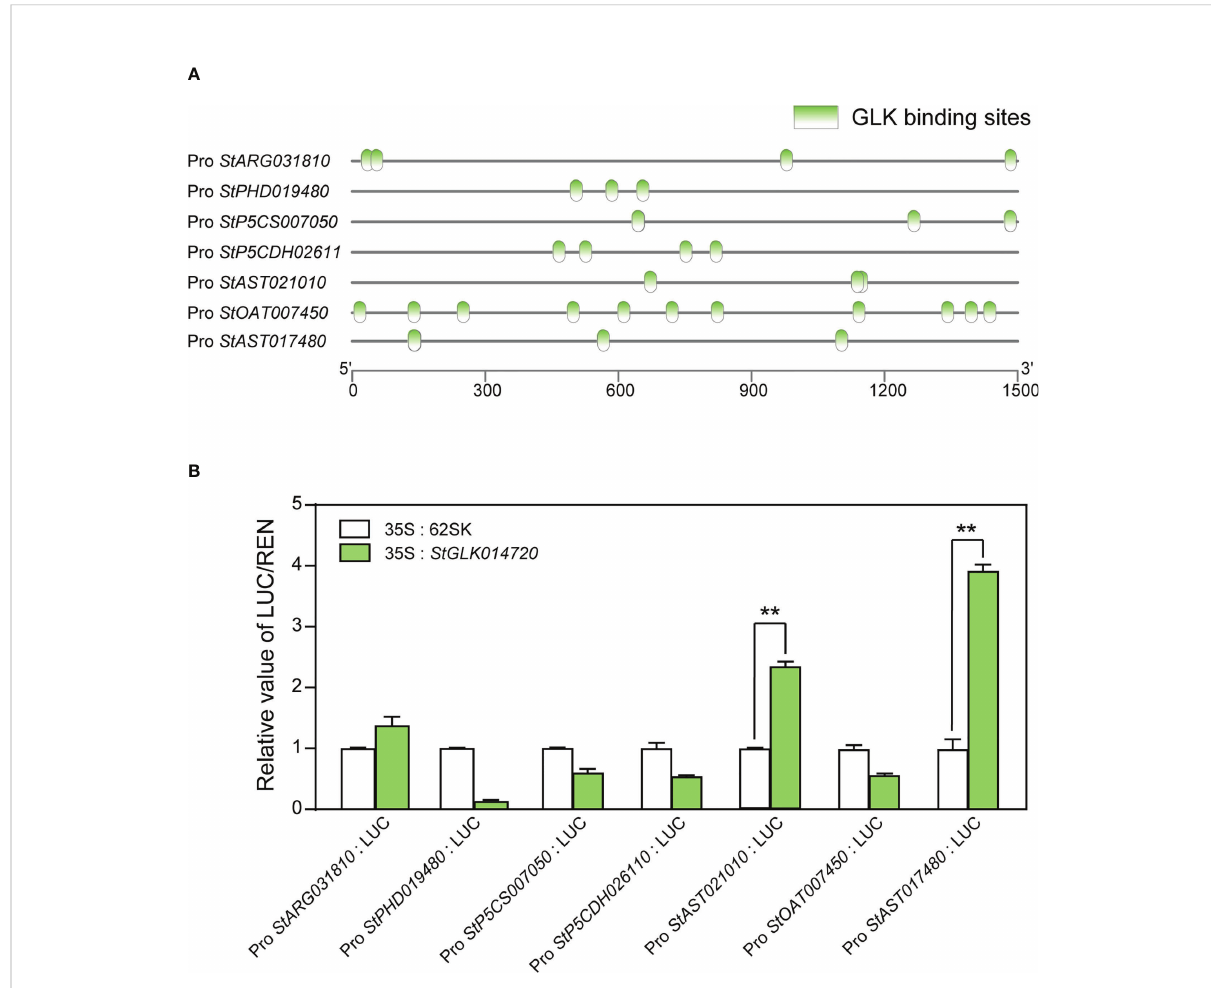
FIGURE 6 TFBs prediction and dual luciferase reporter assay between the protein StGLK014720 and the seven structural DEGs in the proline metabolic pathway. (A) Prediction of GLK binding sites in the promoter regions of the 7 structural DEGs in the proline metabolic pathway. (B) The ratios of LUC activity relative to REN activity represent the relative activities of the proline structural gene promoters. The LUC/REN ratios of the control were set to 1, to which the ratios of other groups were normalized. Data presented as means ± standard error from three biological replicates were tested by the Student t -test (** P